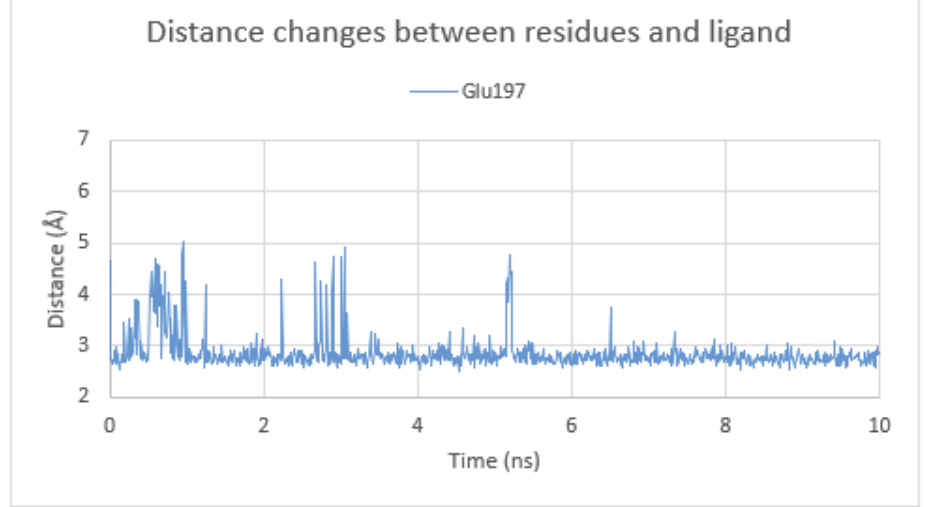
Figure 10. Distance changes between (N)Lig and (O)Glu197 in the BuChE active site during molecular dynamics simulation.